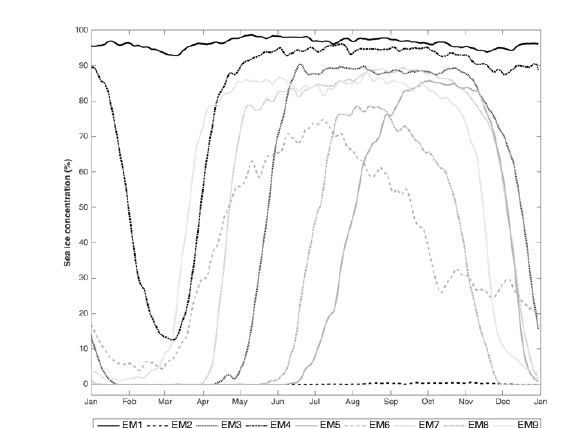
Figure 3. Extracted temporal endmembers